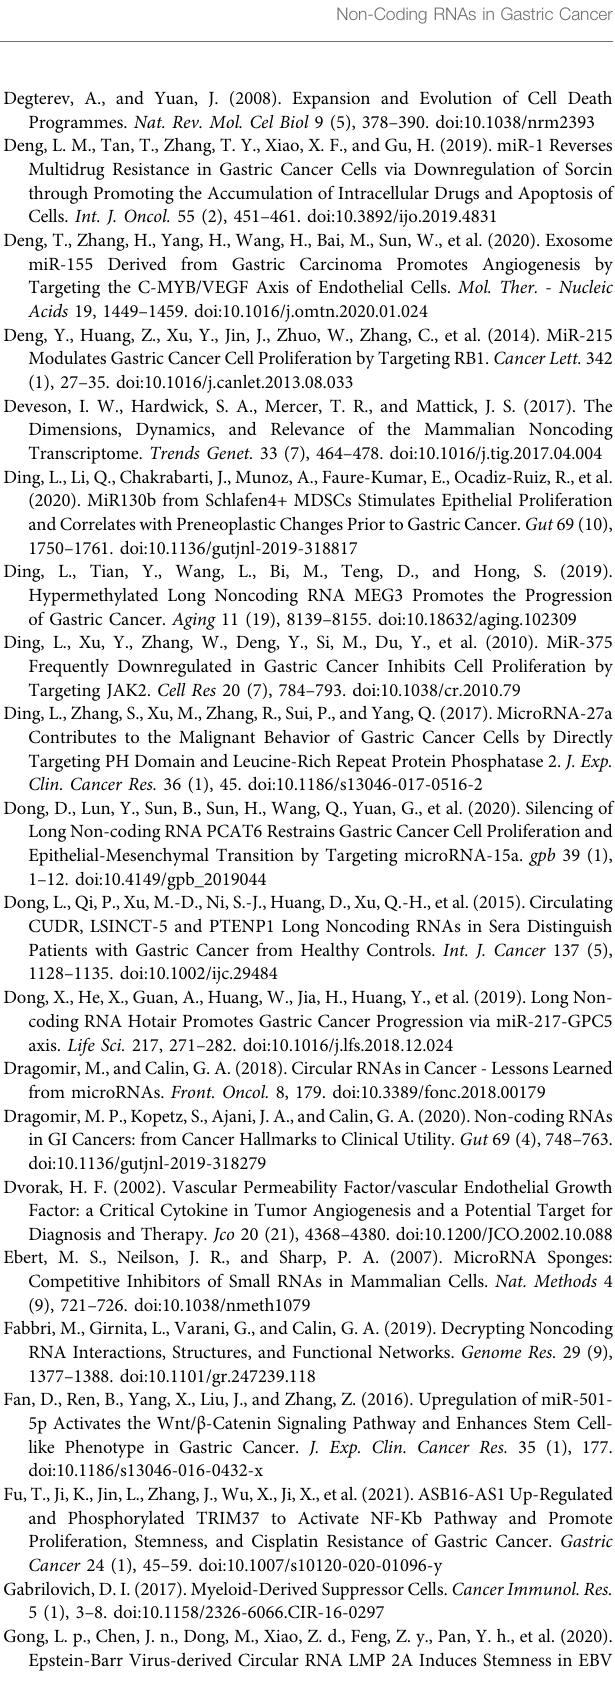
Frontiers in Cell and Developmental Biology |